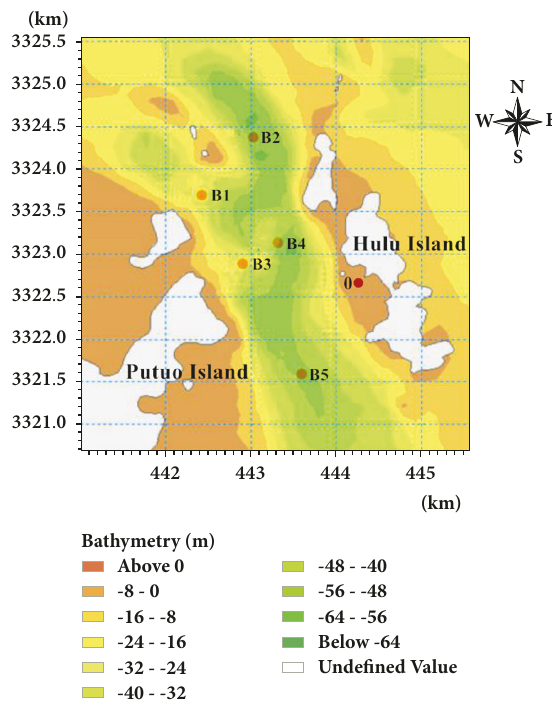
Figure 2: Tidal turbine location.